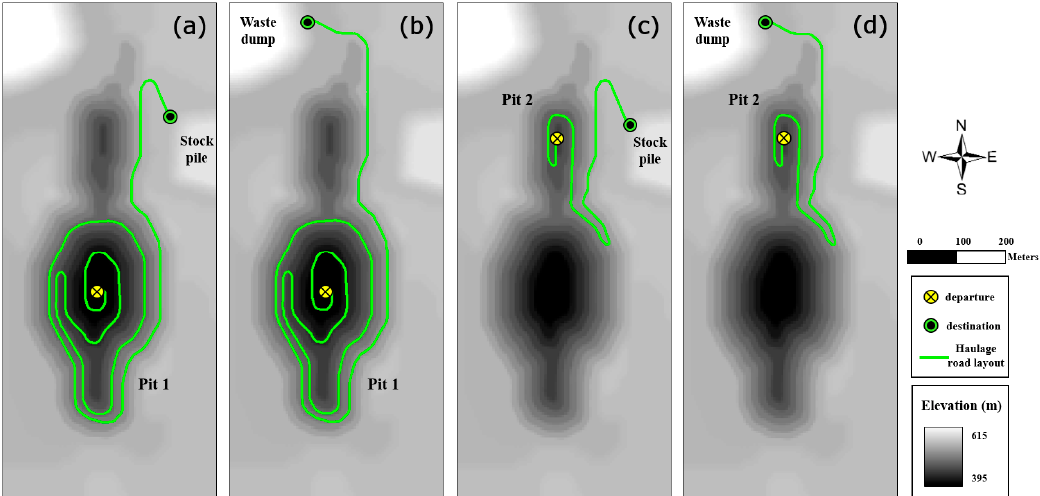
Figure 15. Results of modifying the road layout in Pit 1 and Pit 2 by considering the radius of curvature. The paths connect the loading point in Pit 1 with ( a ) the stockpile and ( b ) the waste dump and the loading point in Pit 2 with ( c ) the stockpile and ( d ) the waste